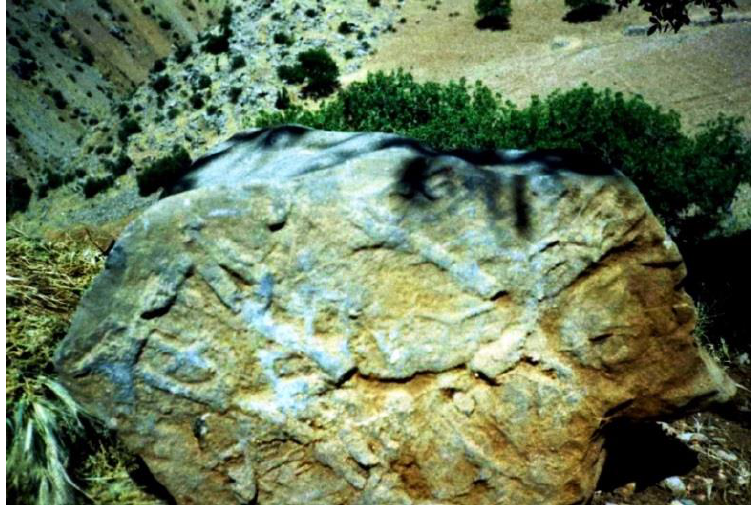
Figure 8. A panel showing anthropomorphs and geometric markings, west of